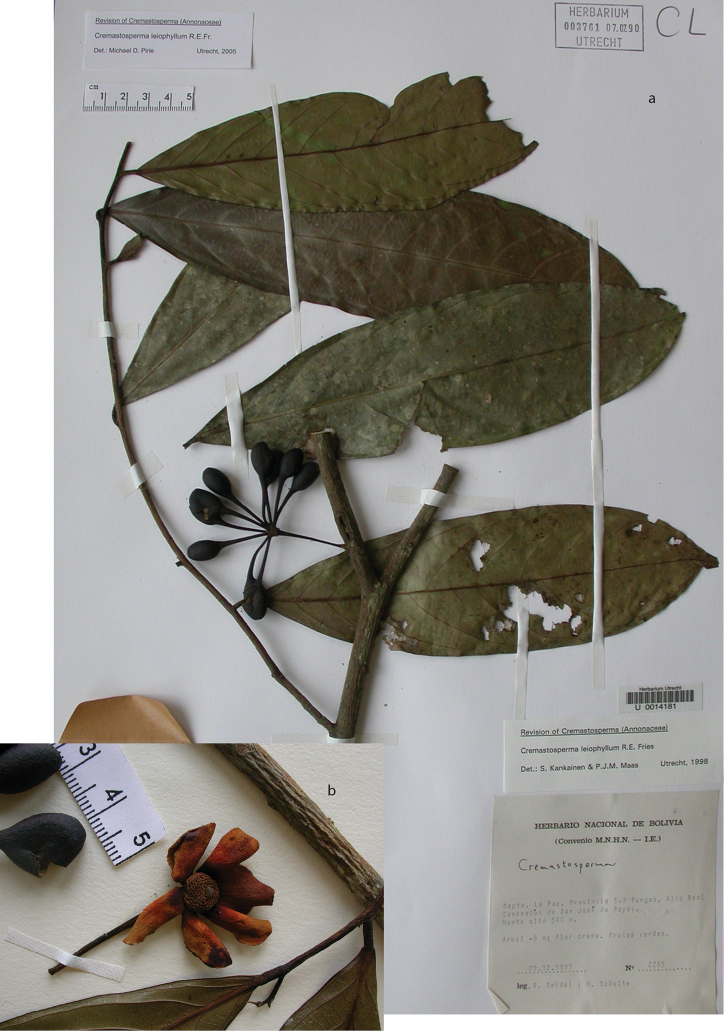
Cremastospermaleiophyllum R.E.Fr. a fruiting specimen b flower (a, bSeidel & Schulte 2265)